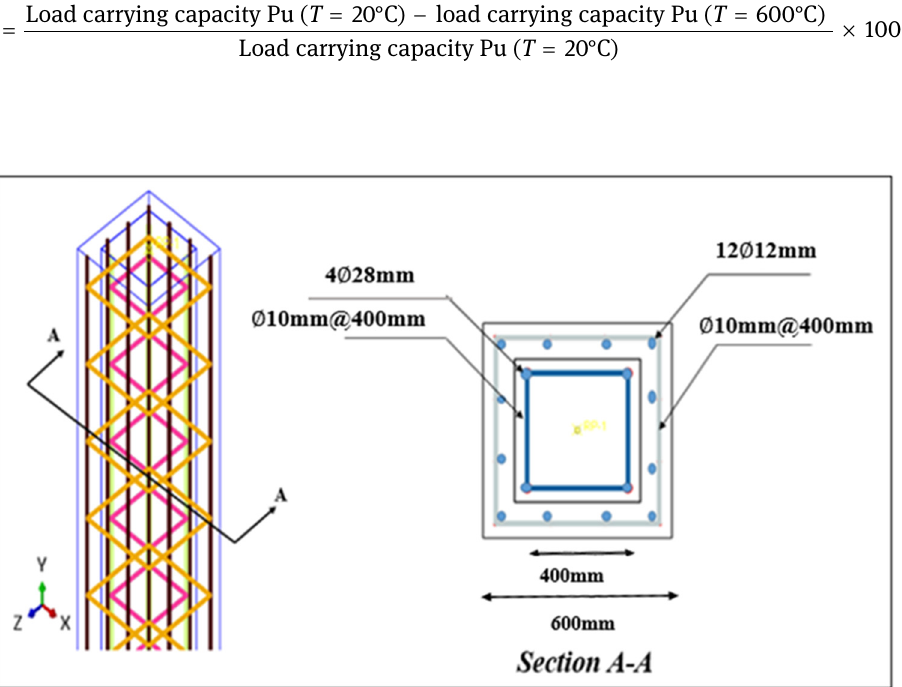
Figure 16: Details of strengthened RC